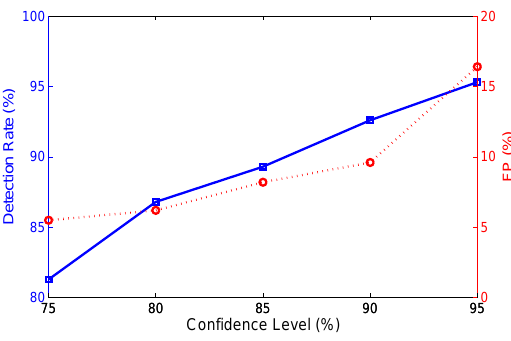
Figure 16. The impacts of confidence